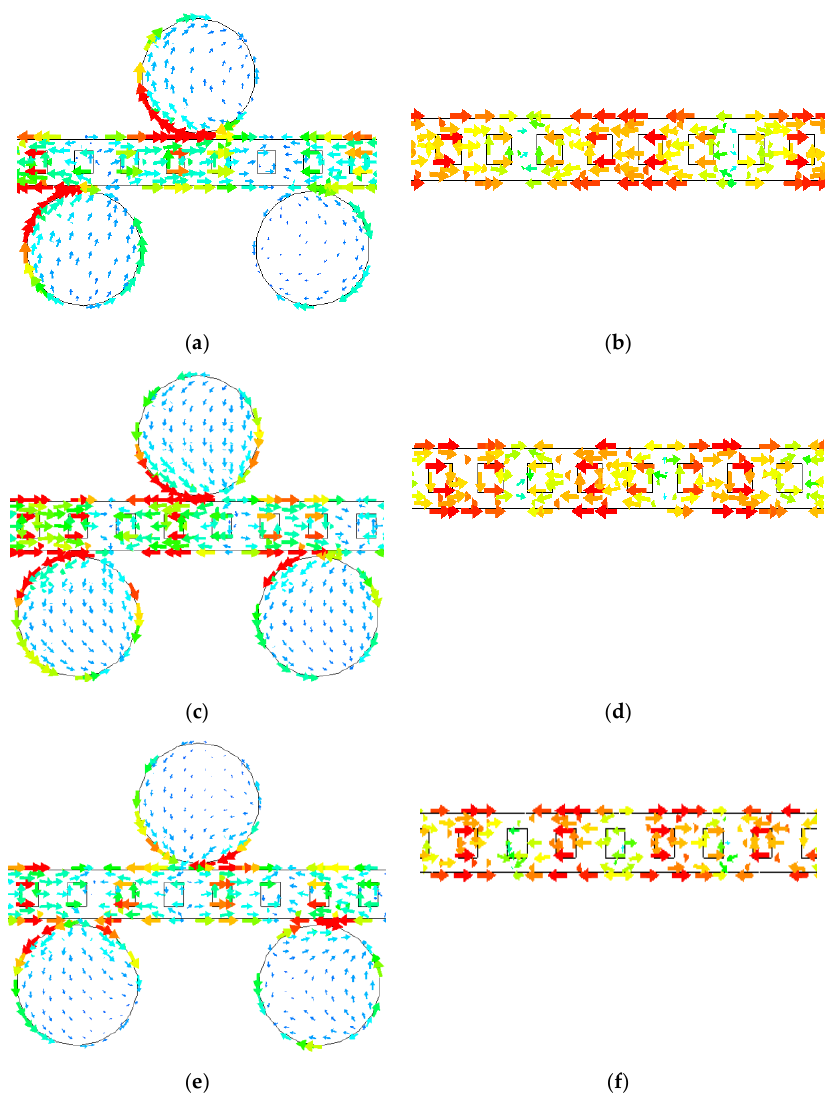
Figure 8. The surface current distribution on SSPP leaky-wave antenna (LWA) and SSPP TL. ( a ) SSPP LWA at 8 GHz; ( b ) SSPP TL at 8 GHz; ( c ) SSPP LWA at 12 GHz; ( d ) SSPP TL at 12 GHz; ( e ) SSPP LWA at 15 GHz; ( f ) SSPP TL at 15 GHz.